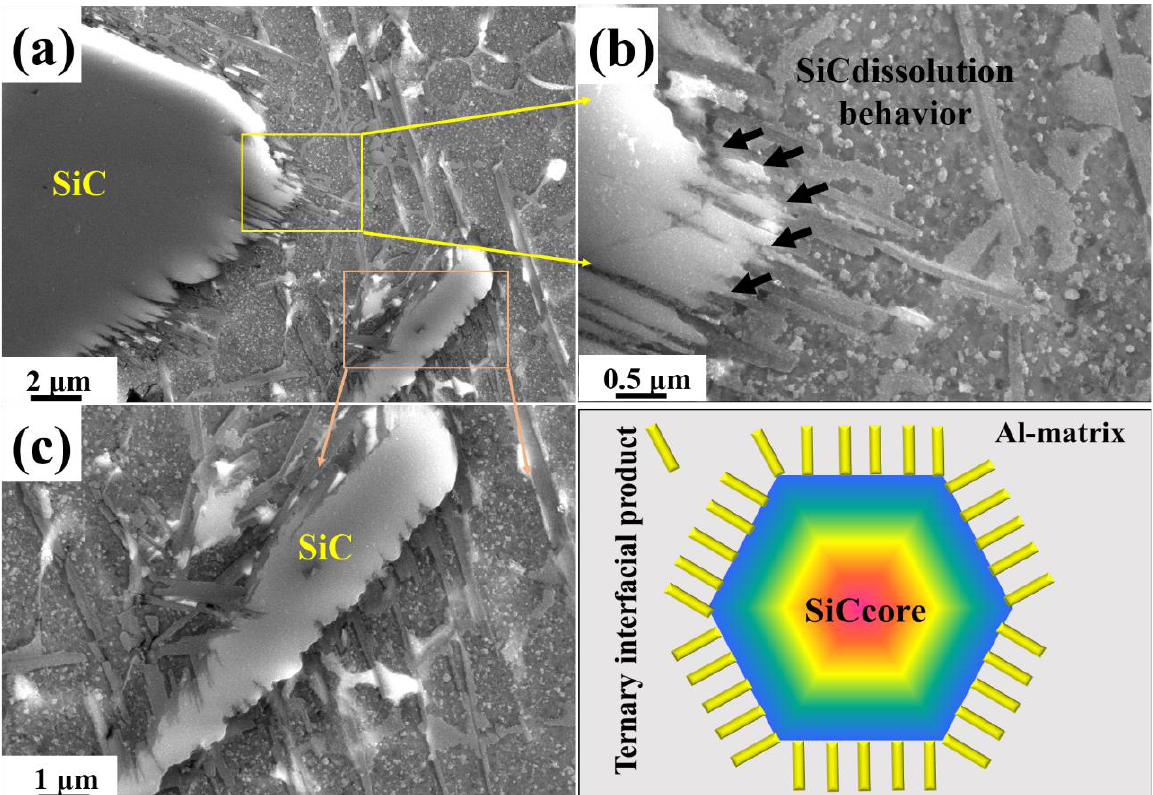
Figure 5. Characteristic SEM image of SiC and schematic diagram of its dissolution behavior in the sample Y2. ( a ) Microstructure near dissolved SiC in a weld; ( b , c ) SEM detail image of feature region in ( a ); ( c ) Schematic diagram of SiC dissolution